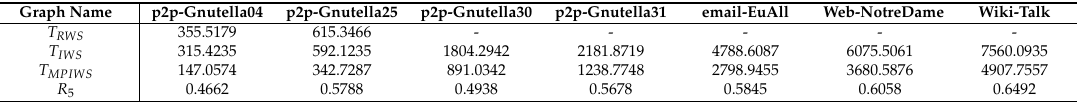
Table 2. Performance Analysis of Algorithms (time unit: ms. ‘-‘ means it has no value).